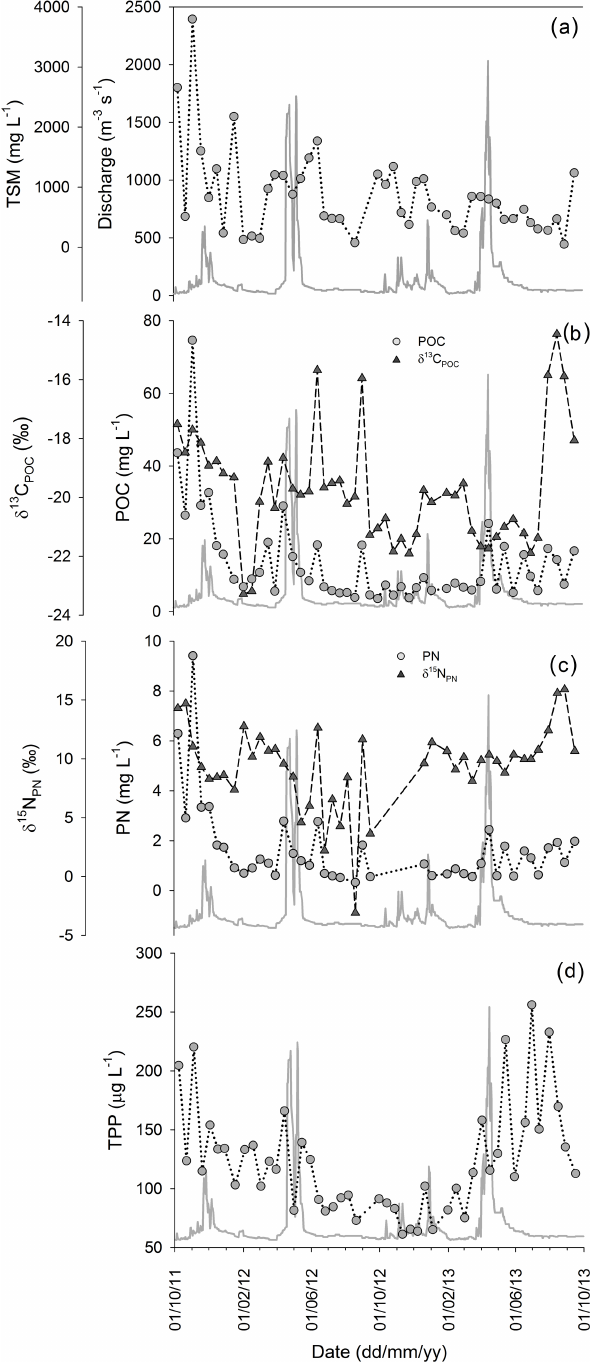
Figure 3. Discharge (solid grey line) and 2 years of monitoring the (a) total suspended matter concentration, the concentration and sta- ble isotope signature of (b) particulate organic carbon and (c) partic- ulate nitrogen and the concentration of (d) total particulate phospho- rus in the Sabaki River. In all figures grey circles represent bulk con- centrations and dark triangles represent stable isotope